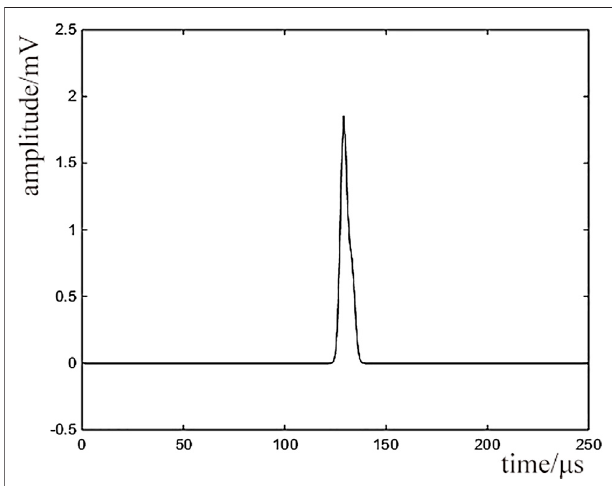
FIGURE 9 | Nuclear pulse signal obtained by sparse decomposing and